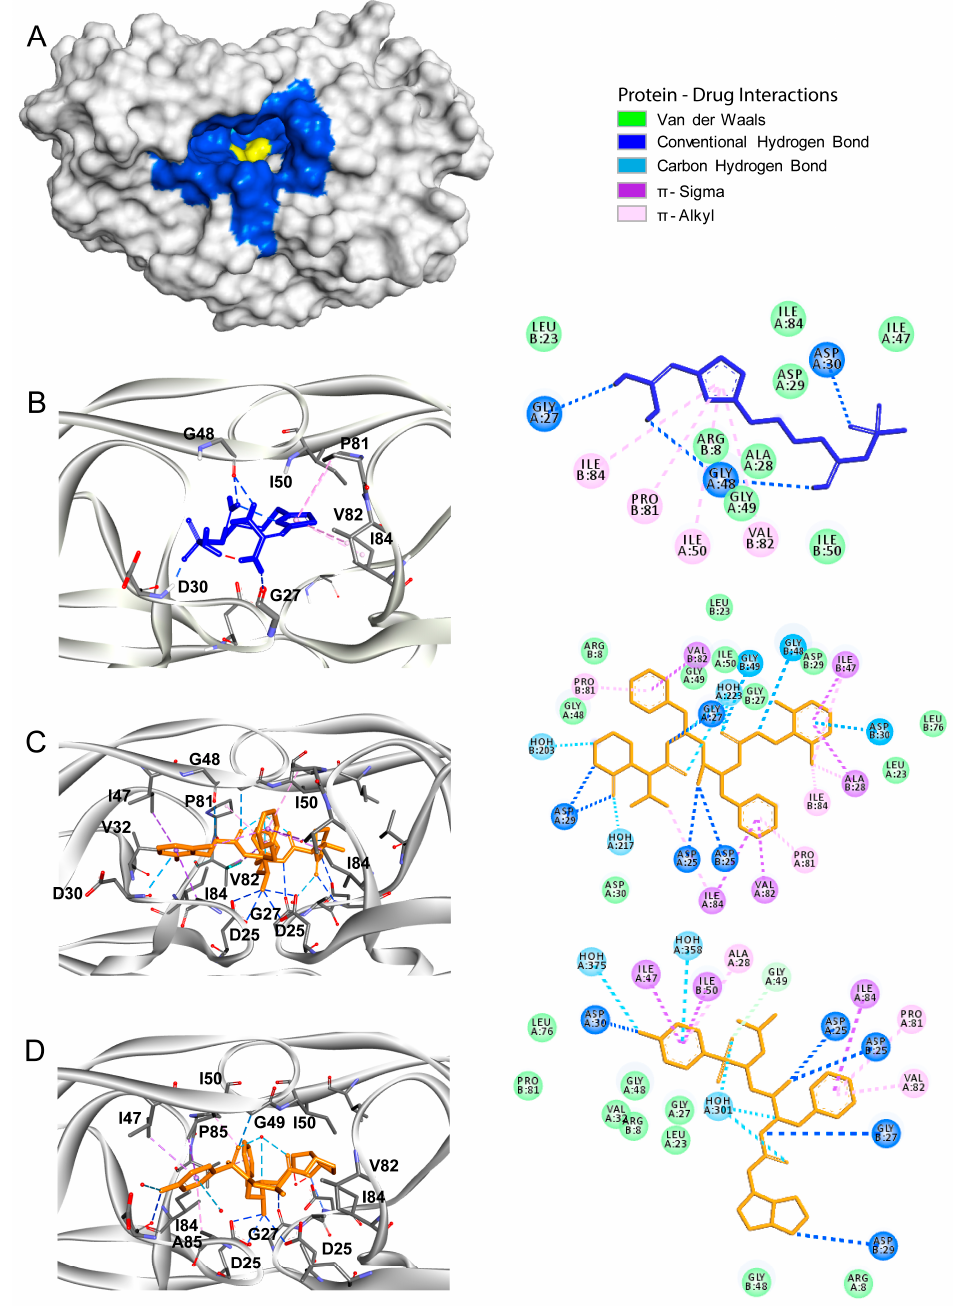
Figure 5. The human immunodeficiency virus (HIV) protease as a target for famotidine. ( A ) The surface representation of the HIV protease crystal structure (PDB ID: 3LZS). The catalytic site is shown in blue and the catalytic residues Asp25, Thr26, and Gly27 are shown in yellow. ( B ) Molecular docking of famotidine into the catalytic site of the HIV protease. The 3D structure of the protein–drug complex is shown on the left. The protein is represented in ribbon, and famotidine is shown as dark blue sticks. The main interacting residues are indicated. The 2D diagrams of the main interaction networks between famotidine and the residues within the protease active site are shown on the right. The specific types of interactions are indicated in the legend. ( C , D ) The 3D structures of HIV protease bound to lopinavir (PDB ID: 2Q5K) and to darunavir (PDB ID: 4LL3) obtained from the protein data bank are shown on the left. The 2D diagrams of the main interaction networks between the drug ligand and the residues within the protease active site are shown on the right. The final 3D structures and 2D diagrams of the protein–drug complexes were visualized with the Biovia Discovery Studio Visualizer 17.2.0